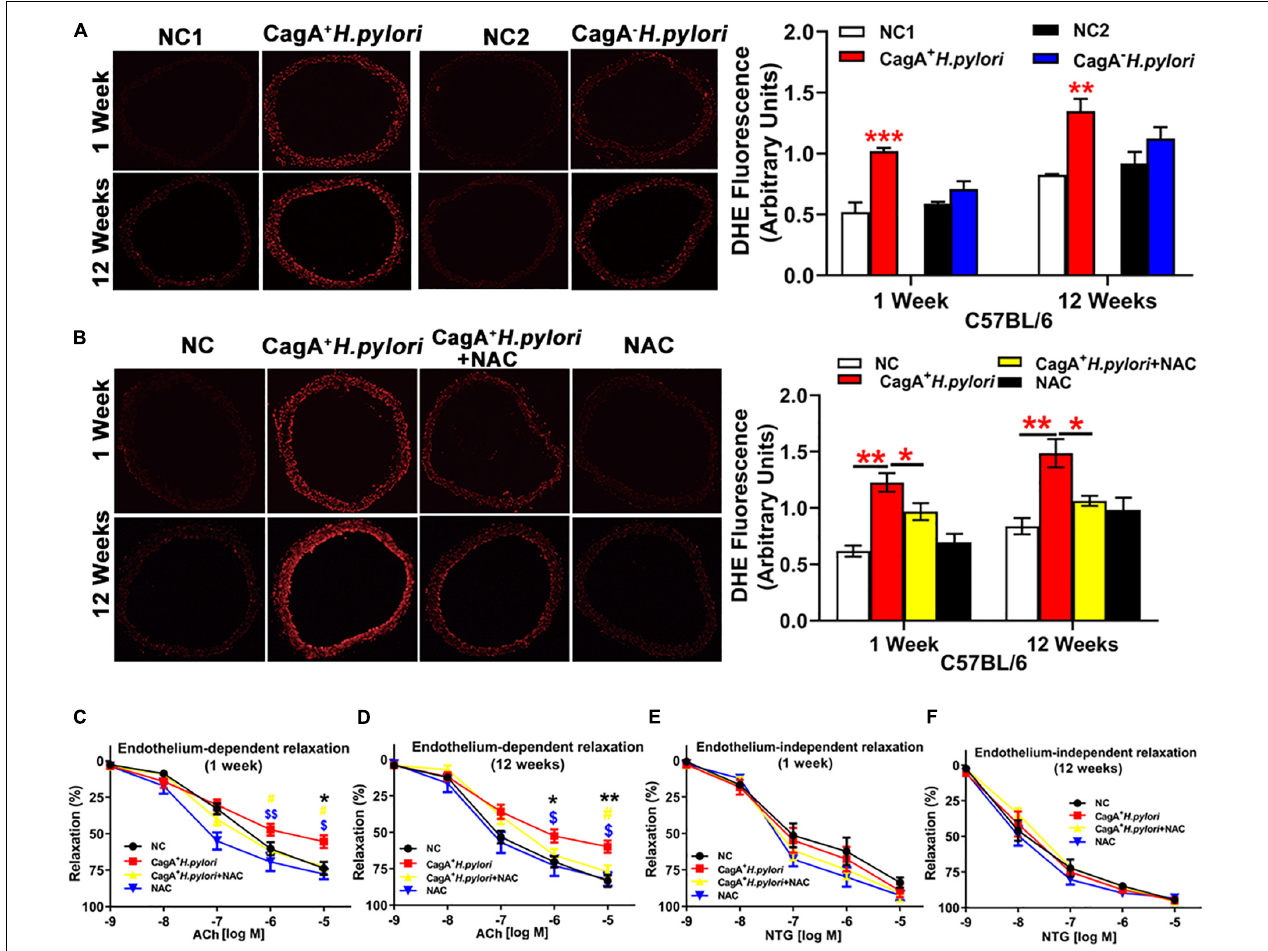
FIGURE 2 | CagA + H. pylori , not CagA − H. pylori infection, impaired endothelial function through increased ROS production in mice. Representative fluorescent images and quantification of ROS formation in the aorta of male C57BL/6 mice (A) (** P < 0.01, *** P < 0.001 by t -test) with CagA + H. pylori , CagA − H. pylori or PBS gavage. Aortic ROS production was significantly increased in mice with CagA + H. pylori infection, not with CagA − H. pylori infection. Treatment with NAC prevented aortic ROS production (B) (* P < 0.05,** P < 0.01 by one-way ANOVA) and preserved ACh-induced aortic relaxation (C,D) in mice with 1 or 12 weeks of CagA + H. pylori infection, without change in NTG-induced aortic relaxation (E,F) . * P < 0.05, ** P < 0.01 (compared with NC), # P < 0.05 (compared with CagA + H. pylori + NAC); $ P < 0.05, $$ P < 0.01 (compared with NAC) by one-way ANOVA. NC(1/2): normal control. NAC: N-acetylcysteine; ACh: acetylcholine; NTG: nitroglycerin. Data are presented as mean ± SEM; N = 8–10 mice for each group at each time point.